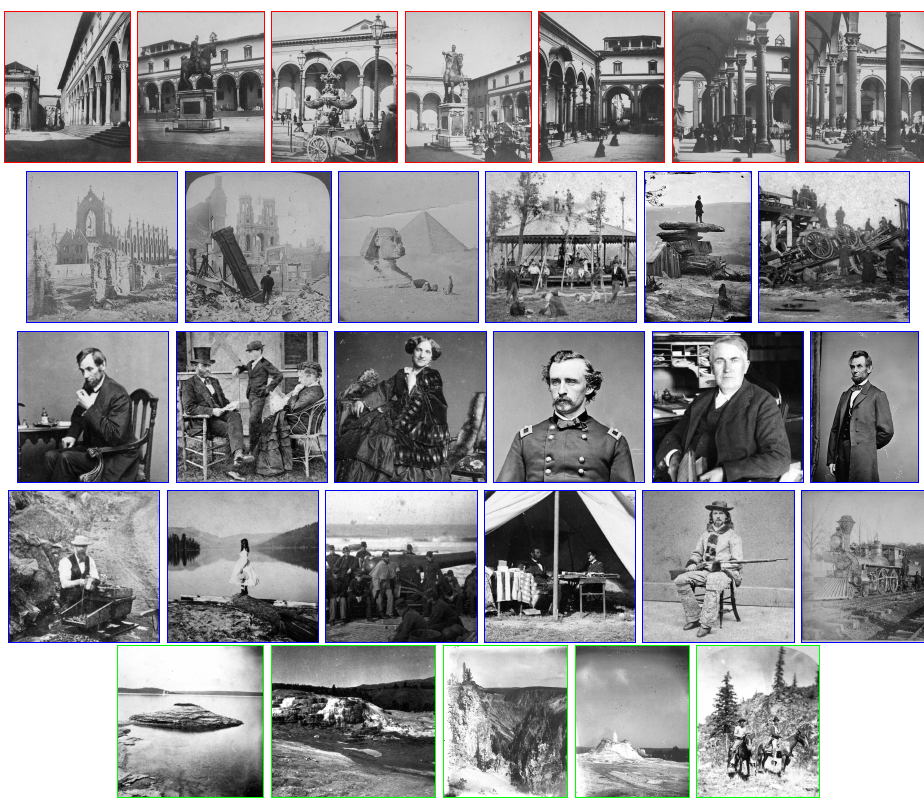
Figure 8. Left frames for some historical stereo pairs. Image frames for Hautmann’s, Stereoscopic Photos and USGS datasets are framed, respectively, in red, blue and green. Best viewed in color and zoomed in with the electronic version of the